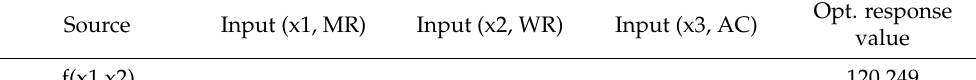
Optimal coded and actual values of inputs with response for every source (function) Source Input (x1, MR) Input (x2, WR) Input (x3, AC)